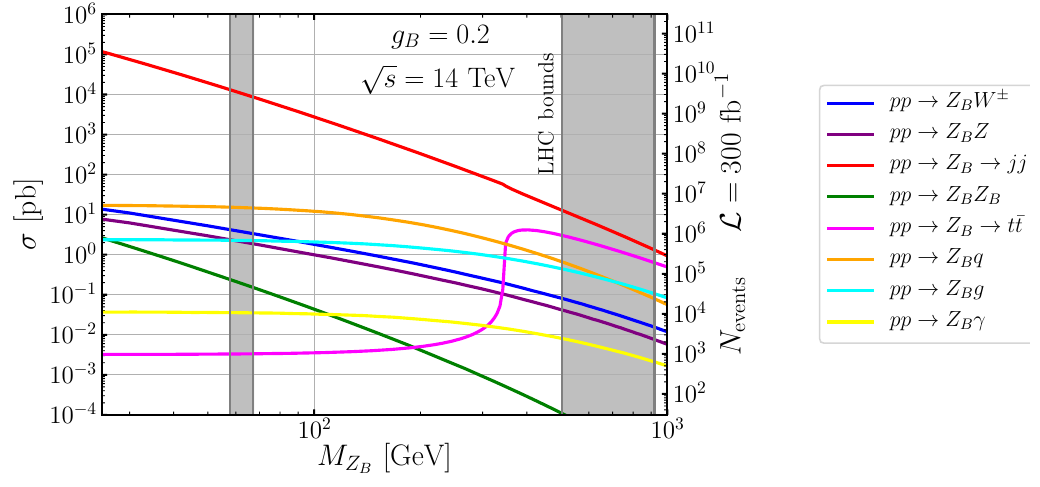
Figure 3 . Production cross-sections at the LHC for center-of-mass energy of 14 TeV in units of picobarns, we (cid:12)xed g B = 0 : 2. On the right side of the vertical axis we show the expected number of events assuming 300 fb (cid:0) 1 for the integrated luminosity. The regions shaded in gray are excluded by LHC searches for the Z B